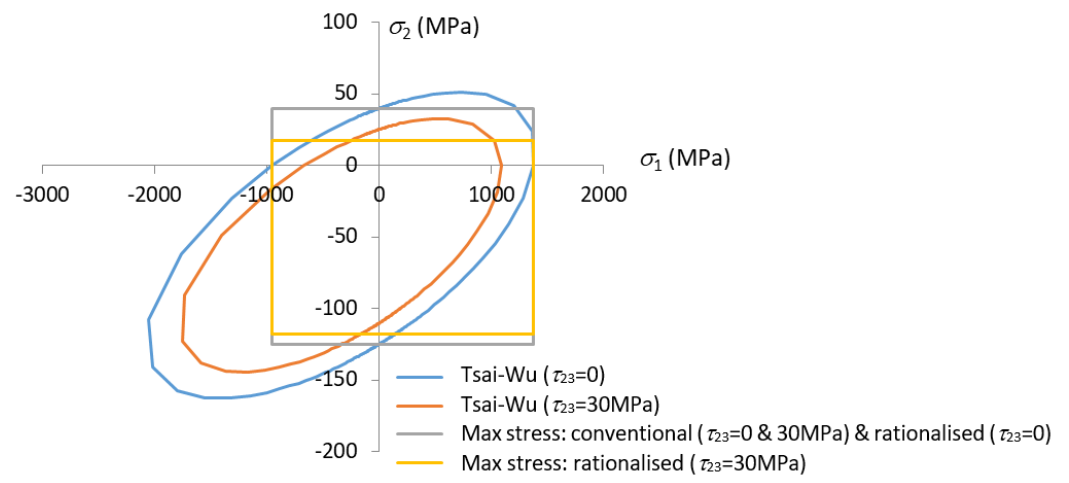
Figure 5. Failure envelopes predicted from the conventional and rationalized maximum stress criterion and compared with those from the rationalized Tsai-Wu criterion.